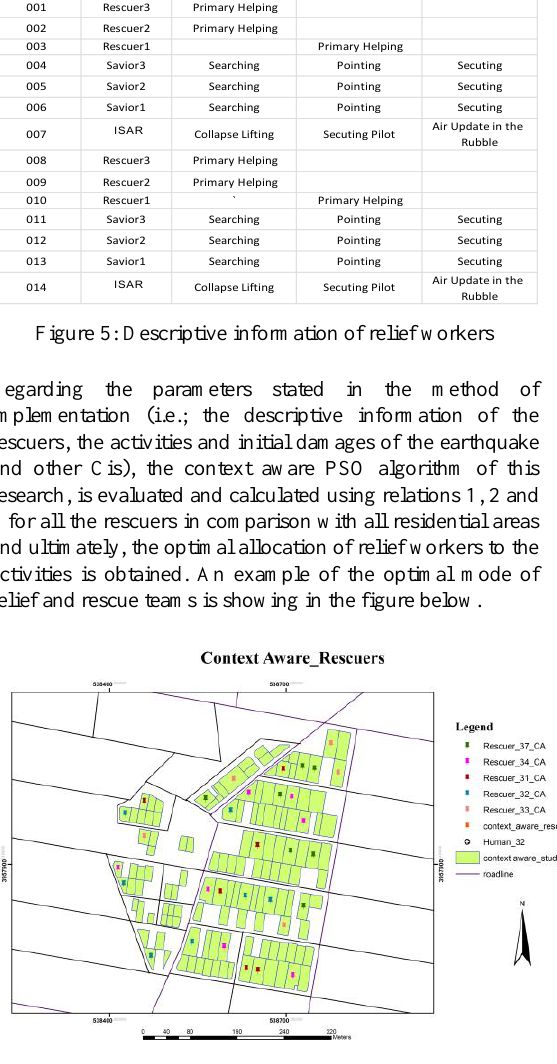
Figure 6: Context-aware Optimization of the Relief & Rescue